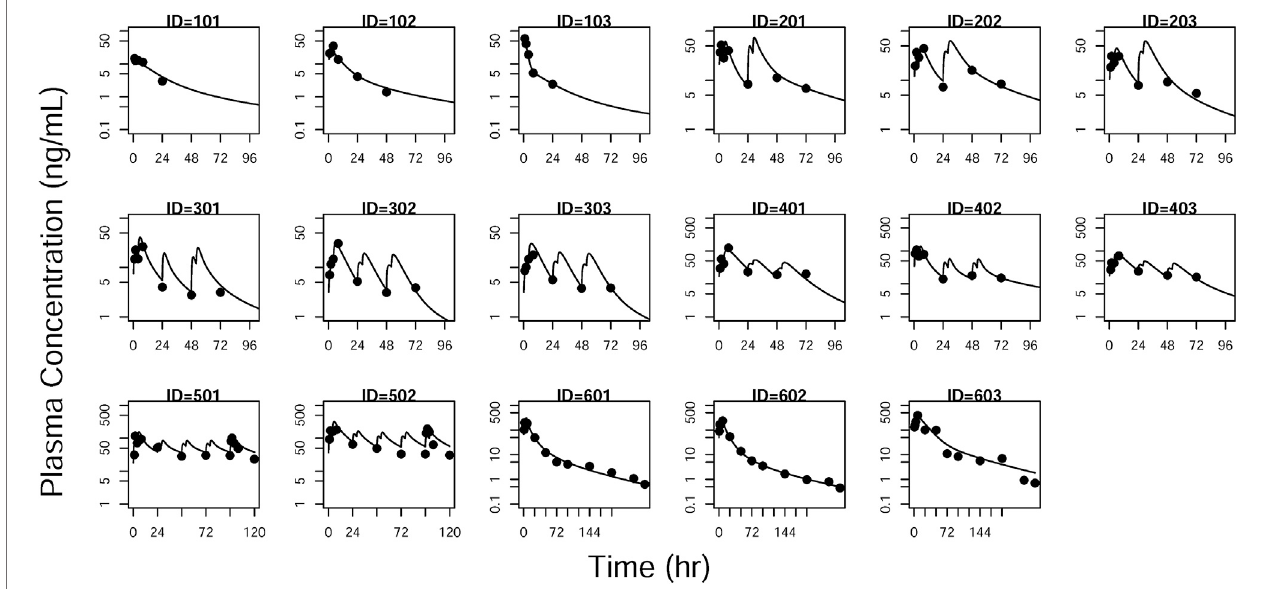
FIGURE 7 | Individual prediction plots for blood concentration. The symbols are the observed data. The lines are the individual fi tting lines from fi nal PK model.